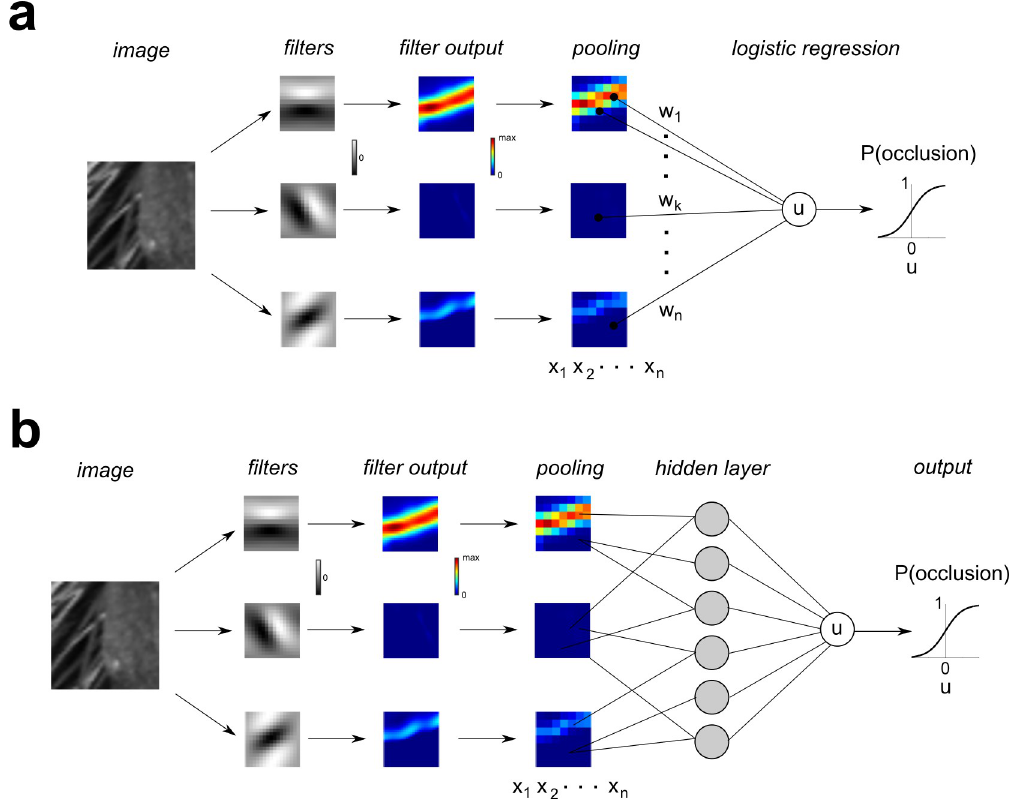
Fig 4. Schematic illustration of Gabor Filter Bank (GFB) and Filter-Rectify-Filter (FRF) classifier models. ( a ) GFB model. An image patch is analyzed by a bank of 72 oriented log-Gabor filters covering 3 spatial scales (8, 16, 32 pixels). The rectified filter outputs are downsampled and MAX pooled to obtain a set of regressors x 1 , ... , x . Binomial logistic regression is n performed to find a set of weights that optimally predict the probability that the patch is an occlusion. ( b ) FRF model. This model is identical to the GFB model, except the regressors x 1 , ... , x n are then passed into a three-layer neural network having K = 4, 6, 10 hidden units ( gray circles ) to determine the probability an image patch is an occlusion